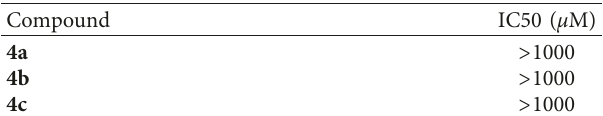
Table 2: Cytotoxic activity of compounds 4a , 4b , and 4c against NIH/3T3 cell